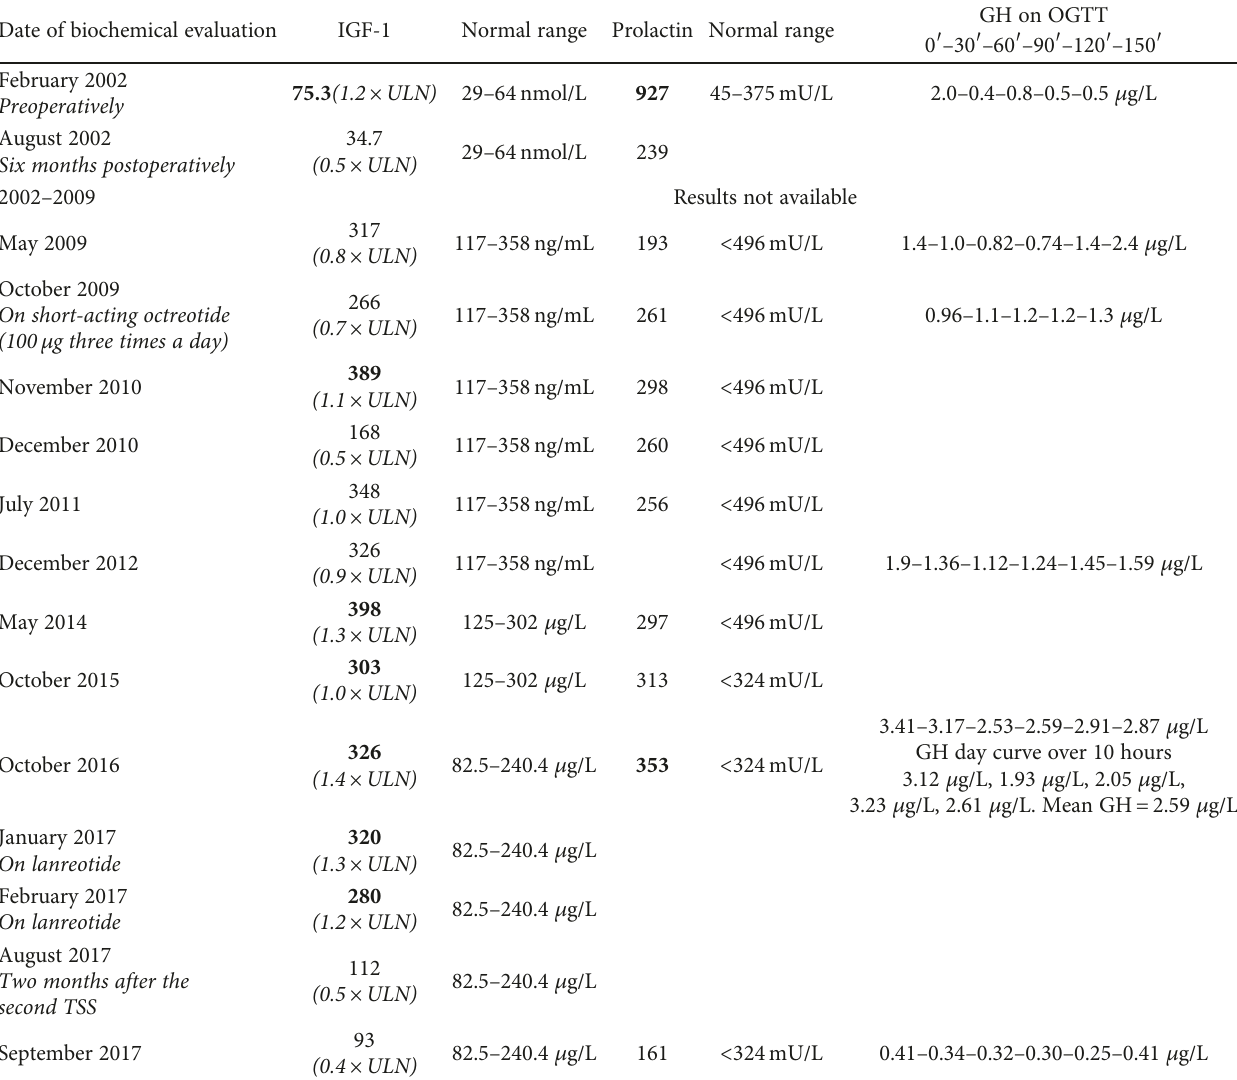
Table 1: Biochemical evaluation of the somatotrope and prolactin axes in the proband ’ s brother (case 2), at diagnosis, postoperatively, and during follow-up. TSS: transsphenoidal surgery; × ULN: times above the upper limit of normal.